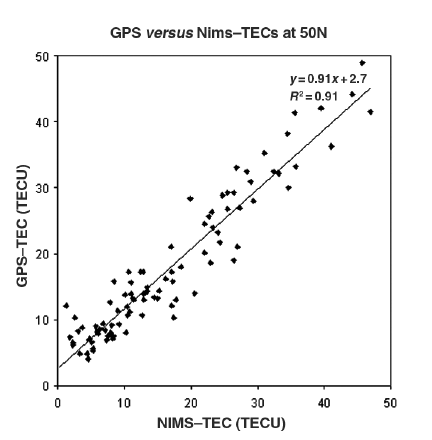
Fig. 8.2. Comparison of equivalent vertical TEC estimated from RINEX files recorded at the IGS-GPS site at Hailsham with values obtained by vertical integration through tomographic images obtained from analysis of NIMS observations at a chain of stations in